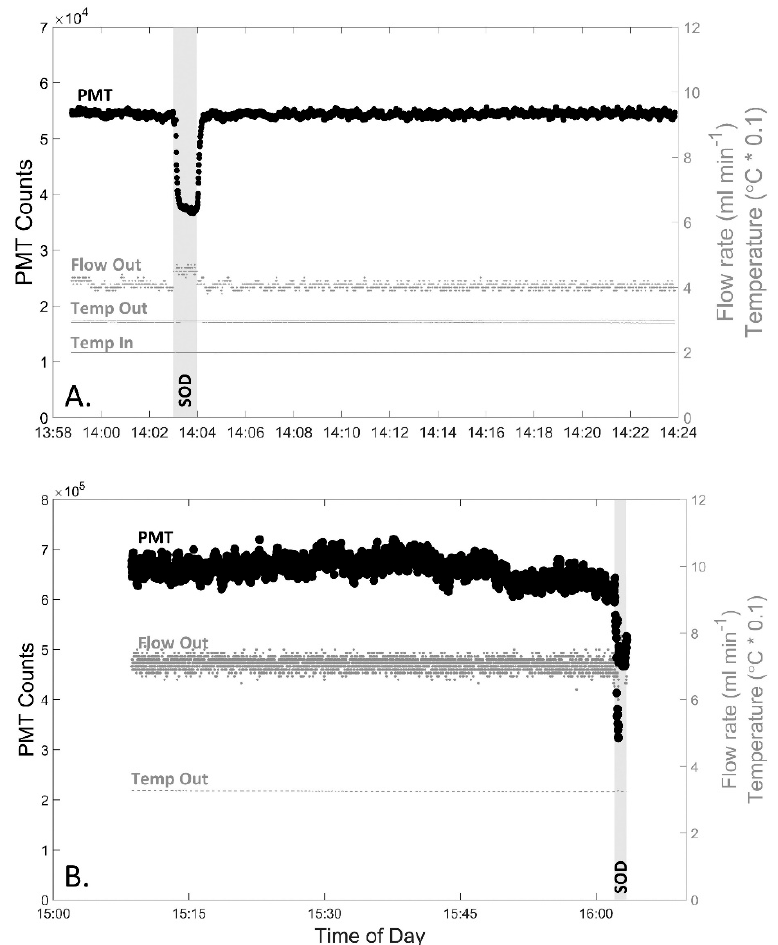
Figure 3. Raw DISCO II data during extended measurements to test for stability and drift within the instrument both in the ( A ) laboratory (~30 min) and ( B ) in situ near a shallow reef (~60 min), PMT settings are default voltage, IT 500ms. Graphs display the PMT counts (left y-axis, black large circles), effluent flow rate (ml min − 1 , right y-axis, grey small circles labeled “Flow Out”), effluent temperature ( ◦ C * 0.1, right y-axis, grey small dashes labeled “Temp Out”), and for graph A only, analyte temperature ( ◦ C * 0.1, right y-axis, grey small dashes for line on bottom labeled “Temp In”) throughout the time of day (x-axis). The time when the SOD pump is turned on is labeled and highlighted in a gray vertical